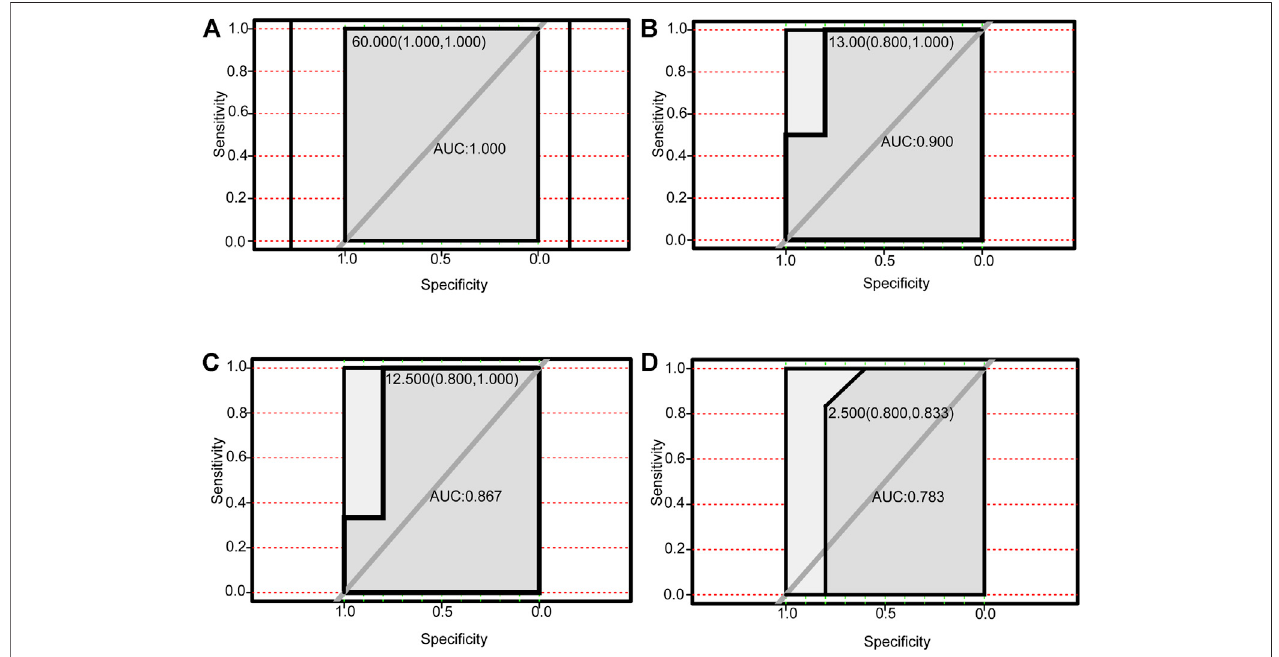
FIGURE 7 | Performance of autophagy-related DElncRNAs for diagnosing NAFLD (GSE160016). (A) ROC analysis of PSMG3-AS1. (B) ROC analysis of MIRLET7BHG. (C) ROC analysis of RP11-136K7.2. (D) ROC analysis of LINC00925.